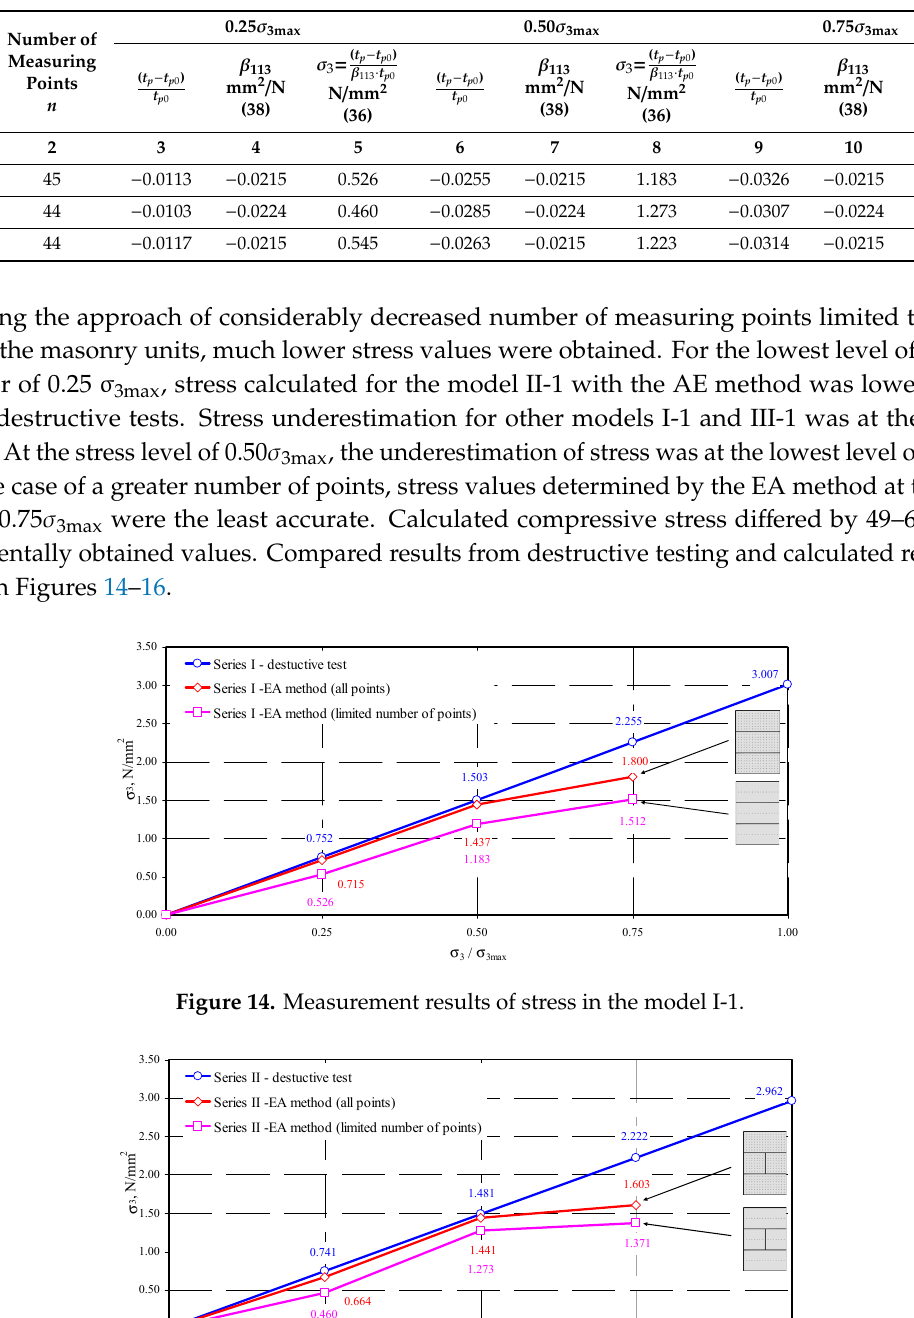
Table 6. Results from calculating normal stress in the wall using a limited number of measuring points.